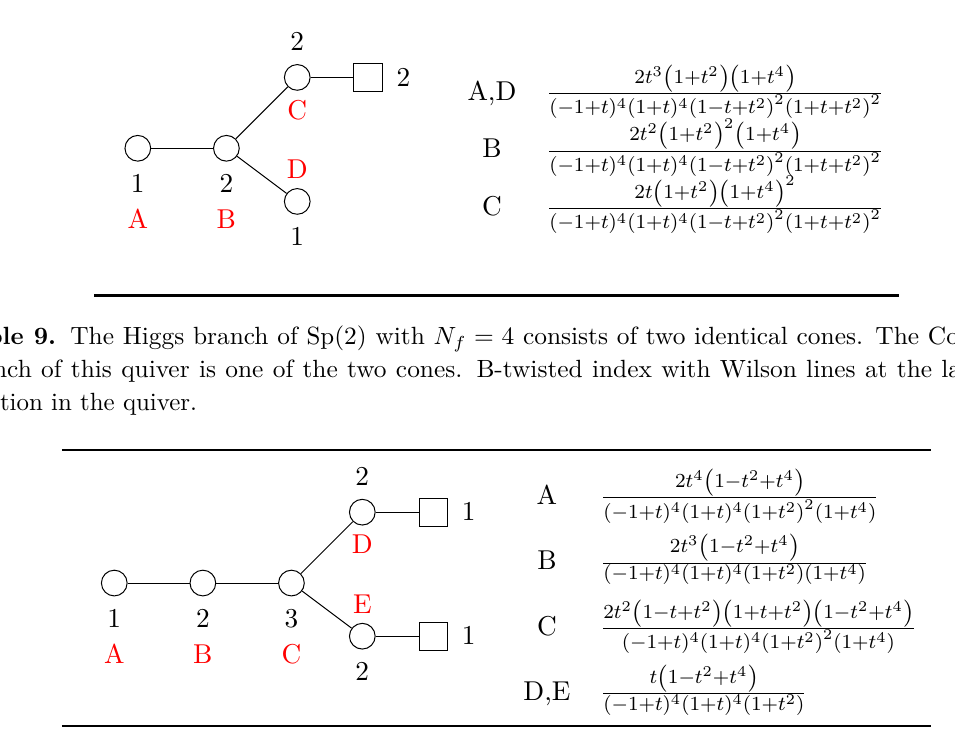
Table 10. Sp(2) with N f = 5 . B-twisted index with Wilson lines at the labelled position in the quiver.